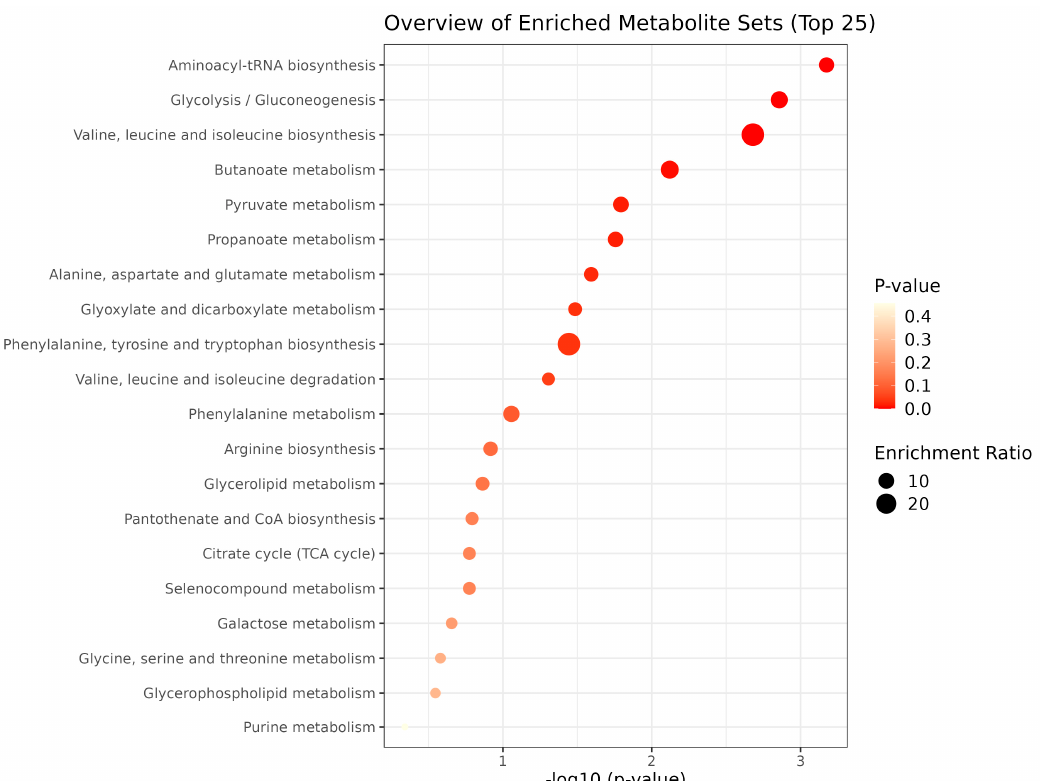
Figure 5. Top 25 metabolic pathways related to the comparison of salivary metabolites from infants < and >30 months